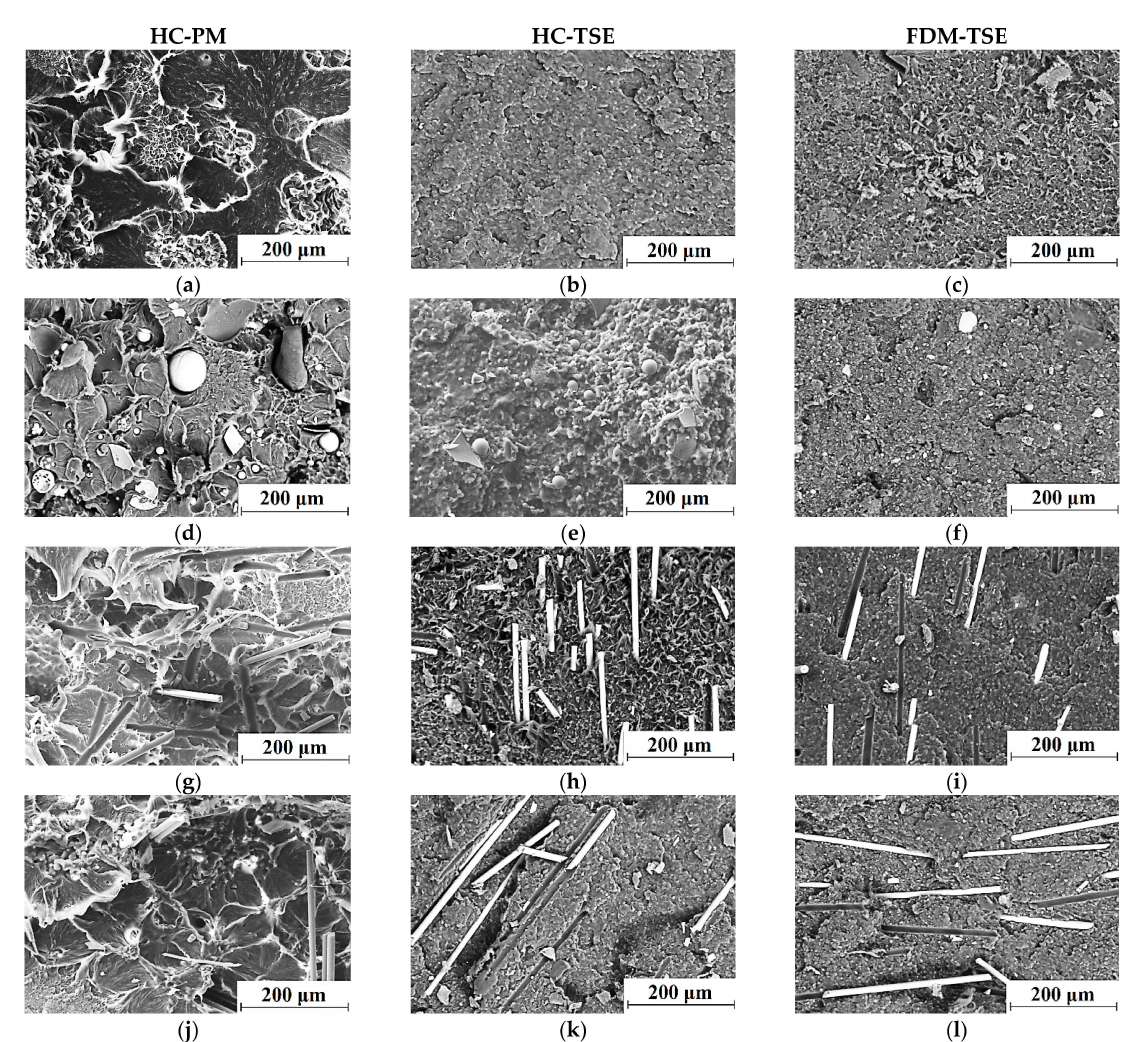
Figure 7. The SEM-micrographs of supermolecular structure of the ‘UHMWPE+17%HDPE-g-VTMS+12%PP’ sample ( a – c ) and the composites ( d – l ) fabricated by the HC-PM, HC-TSE, and FDM-TSE methods: ‘UHMWPE+17%HDPE- g-VTMS+12 %PP+5%HGS’ ( d – f ); ‘UHMWPE+17%HDPE-g-VTMS+12%PP+5%MGF’ ( g – i ); ‘UHMWPE+17%HDPE-g- VTMS+12%PP+5%CGF’ ( j – l